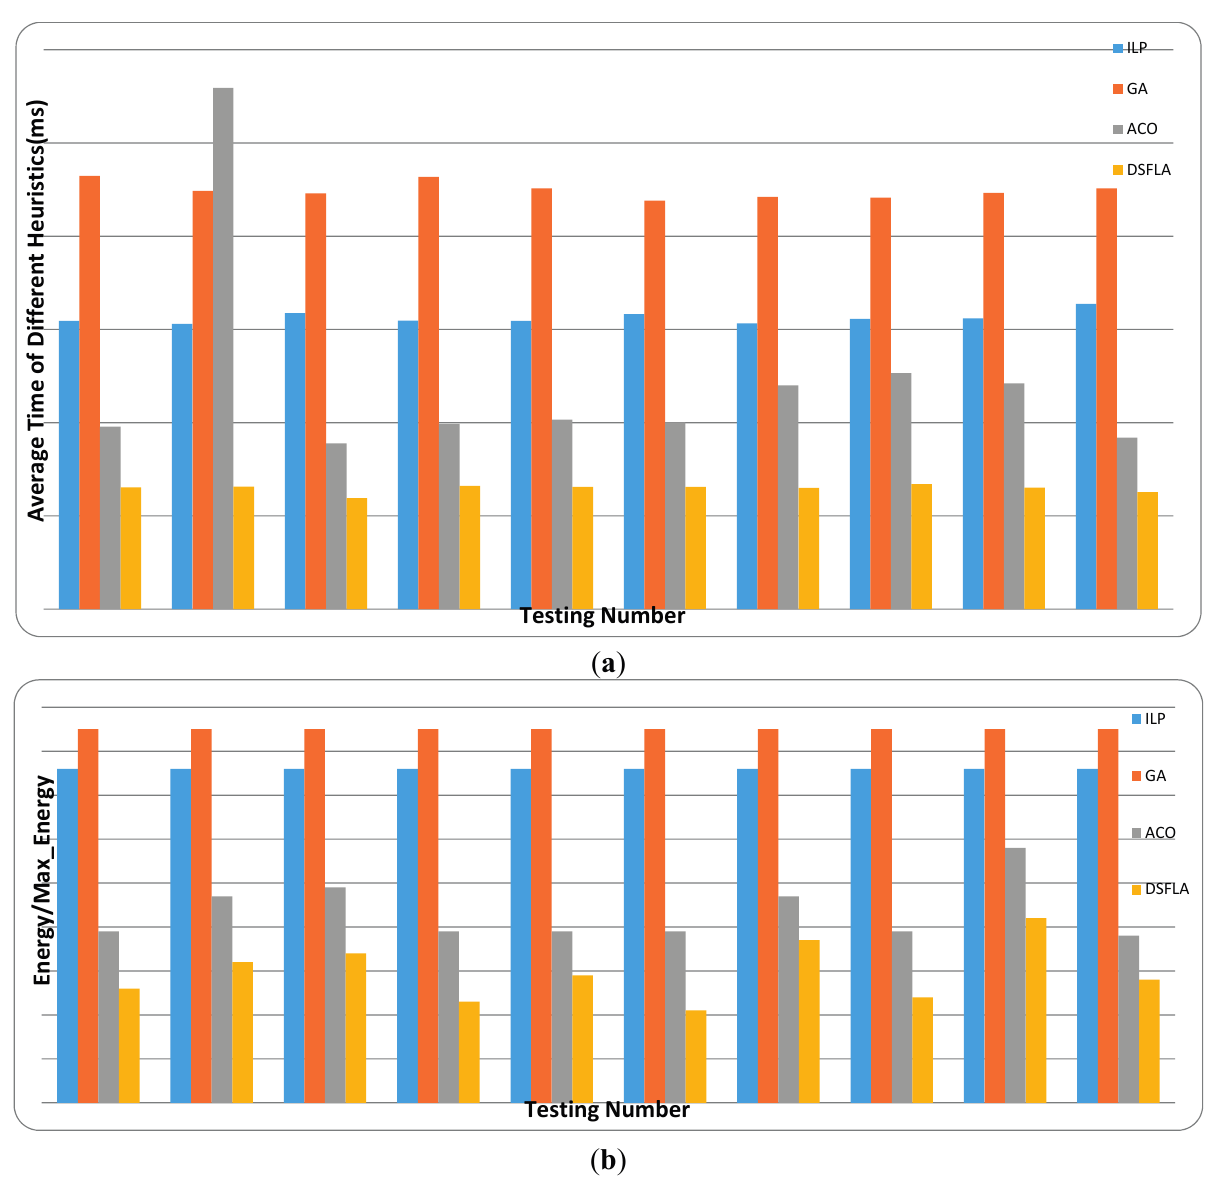
Figure 10. The average runtime and energy consumption of real data set 1 for different heuristics: ( a ) average time and ( b ) energy